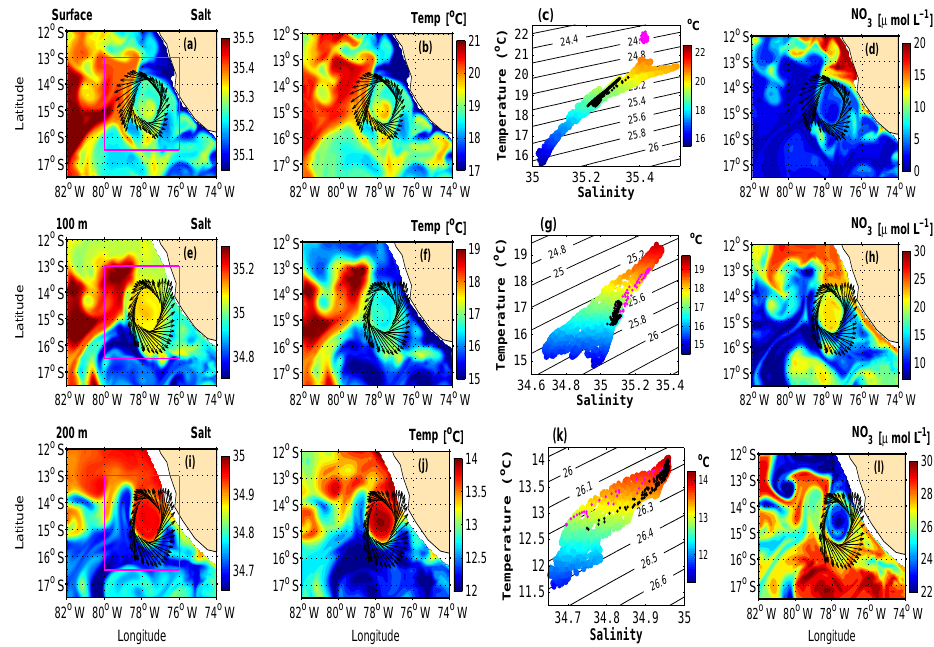
Figure 11. Water mass properties and nitrate distribution around the eddy A sim . Left panels: spatial distribution of simulated salinity at sur- face (top), 100m (middle) and 200m depth (bottom). Middle-left panels: the same as left panel, but for temperature. Middle-right panels: TS relation for surface (top), 100m (middle) and 200m depth (bottom) waters. Right panels: the same as left panels, but for nitrate. The arrows represent the circulation patterns at the eddy’s edge. Black and magenta dots in the TS diagram correspond to the water masses within the eddy at the instant after the eddy formation (magenta) and the instant shown in Fig. 4 (black dots). The magenta box in (a) indicates the region over which the TS diagram is